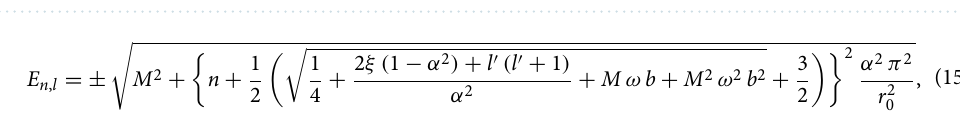
Figure 1. Eigenvalues E n , l keeping fixed M = 1 = r 0 = b , ξ = 1 / 2 [unit of different parameters are chosen in natural units ( c = 1 = (cid:31) )